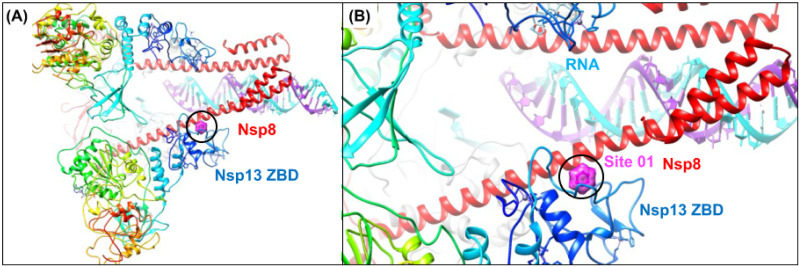
Structure of the Nsp12: Nsp13 replication transcription complex reveals that the Nsp13 zinc-binding-domain (ZBD) mediates protein-protein interactions.(A) A ribbon diagram of the structure of the complex (6xez.pdb) [61] shows how two subunits of the helicase form protein-protein interactions with both Nsp8 (red) and Nsp12 in the active complex through interactions with the helicase ZBD domain (blue). (B) A zoom in view shows that the previously predicted Site 01 on the ZBD (magenta) is proximal (within 5–6 Å) to the Nsp8:Nsp13 protein-protein interaction site in the replication complex.